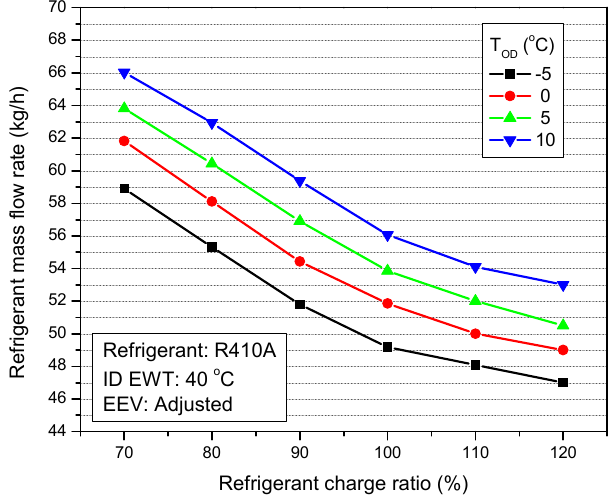
Figure 15. Variation of refrigerant mass flow rate with refrigerant charge ratio and T OD .